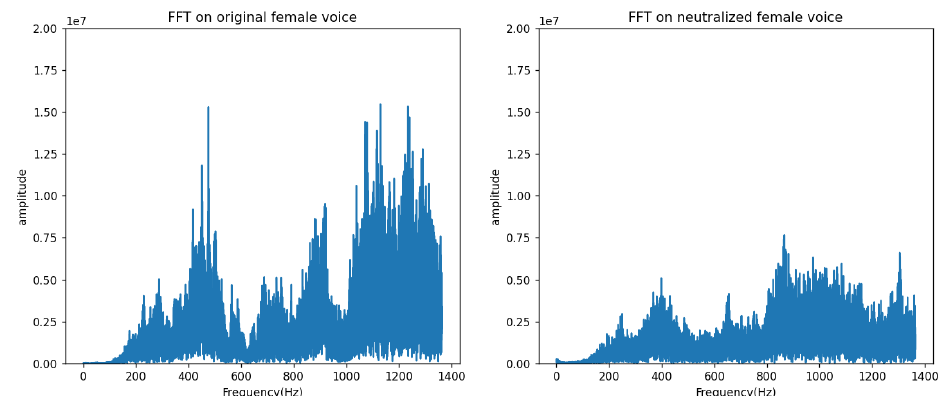
Figure 10. Frequency spectrum of female speech, before and after neutralization.